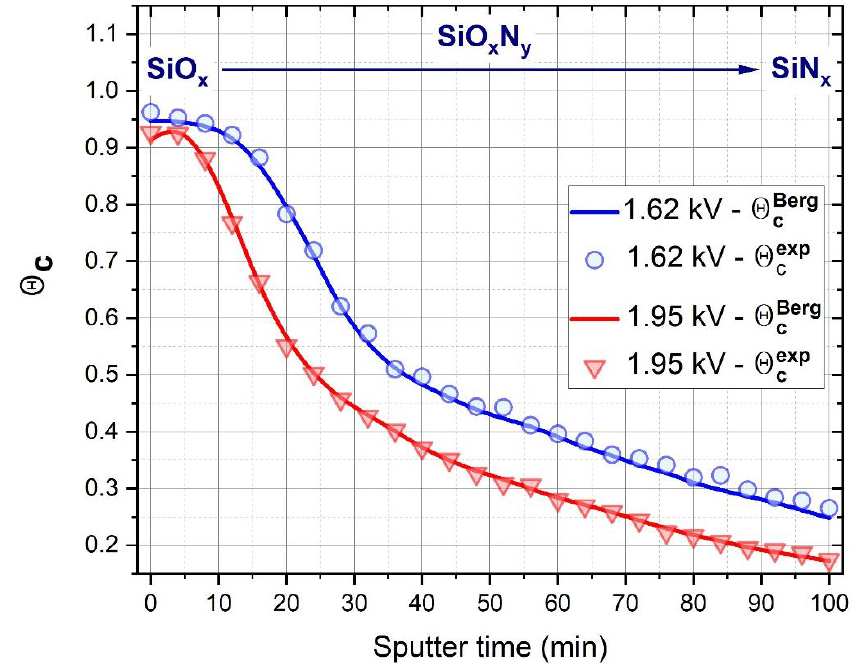
Figure 8. Experimental and Berg-modelled data of the compositional change of the deposited layers as a function of sputter